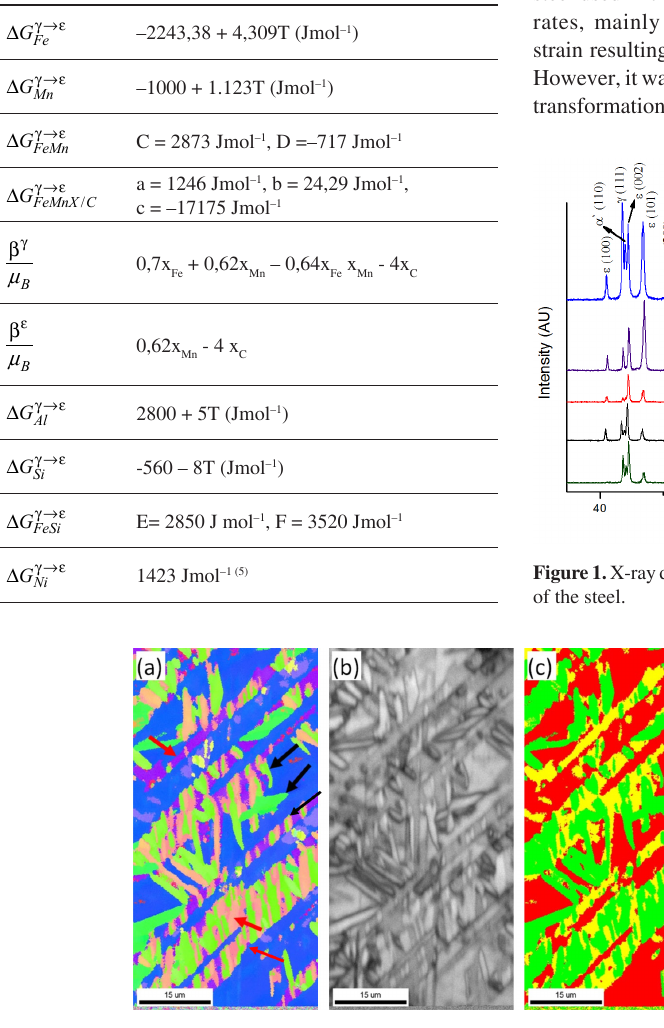
Figure 2. EBSD evaluation. (a) IPF (inverse pole figure), (b) IQ (image quality) map, and (c) phase map for the samples annealed at 1000 °C for 1 h and furnace